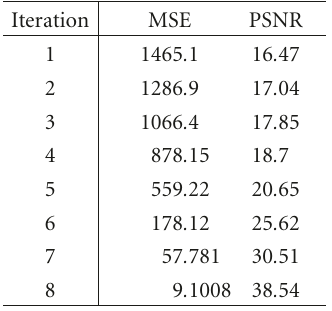
Table 6: Reconstructed image quality using typical turbo code over Rayleigh fading channel.